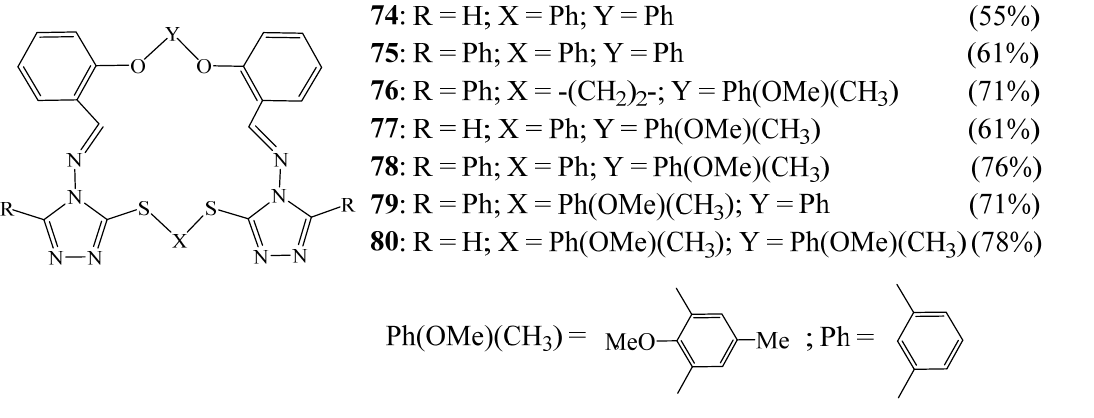
Figure 20. Structures of 1,2,4 Bitriazolic macrocycle 74 − 80. (Reprinted with permission from ref. [36]. Copyright 2007 John Wiley and Sons).